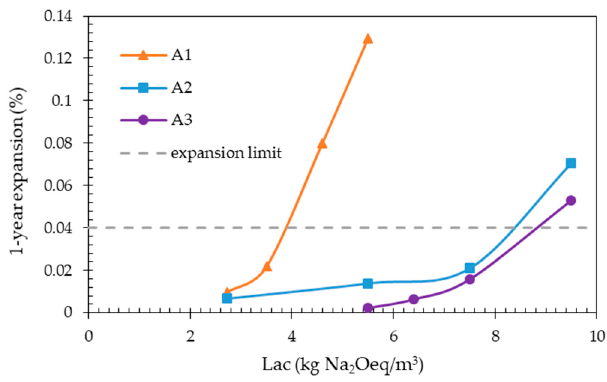
Figure 6. Determination of the threshold alkali level (TAL) values for the three aggregates tested with the traditional CPT.